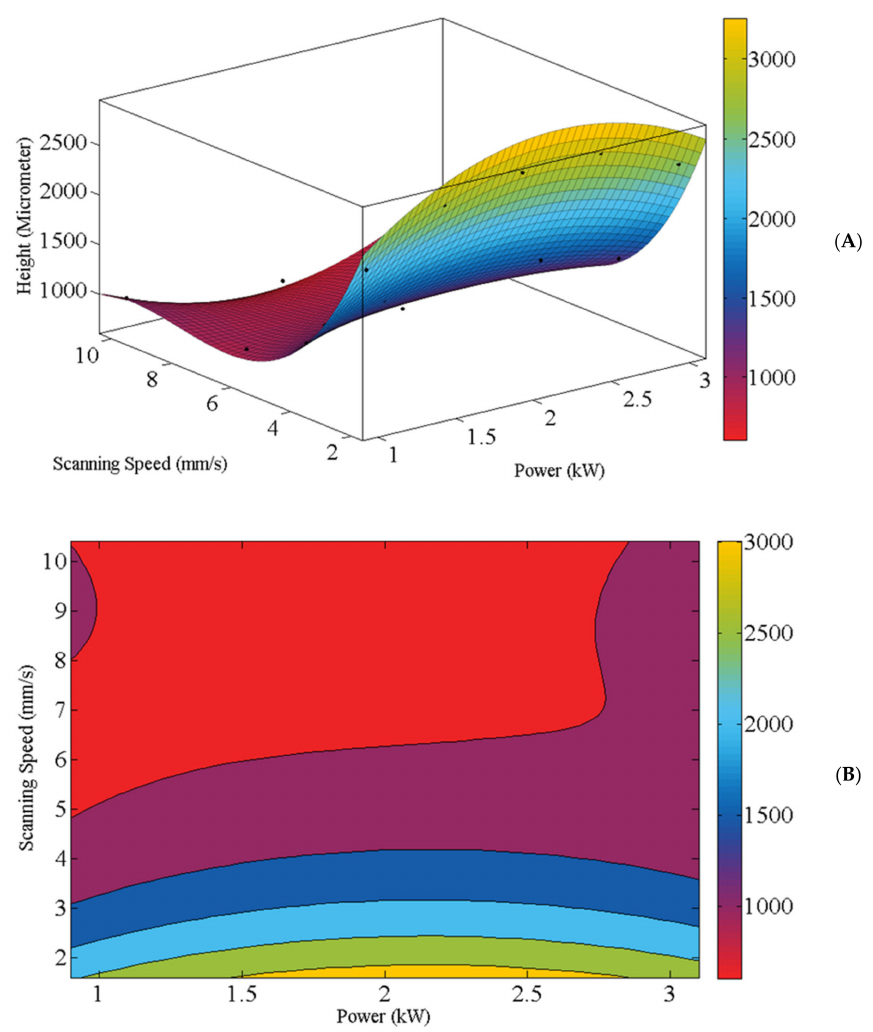
Figure 12. ( A ) The best curved surface (R-square: 0.9908; Adjusted R-square: 0.9539; RMSE: 0.1347) and ( B ) contour plot for the height (in micrometers) of deposited clad regarding the combination of the laser power and scanning